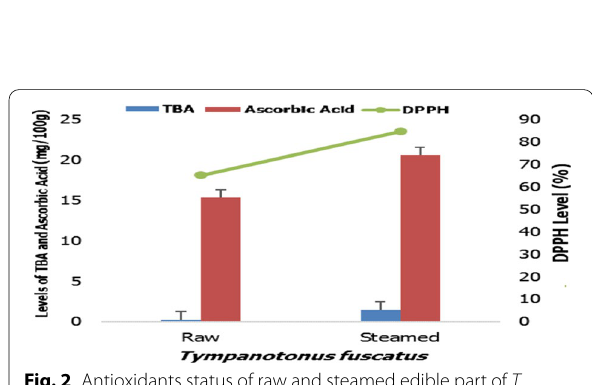
Fig. 2 Antioxidants status of raw and steamed edible part of T.